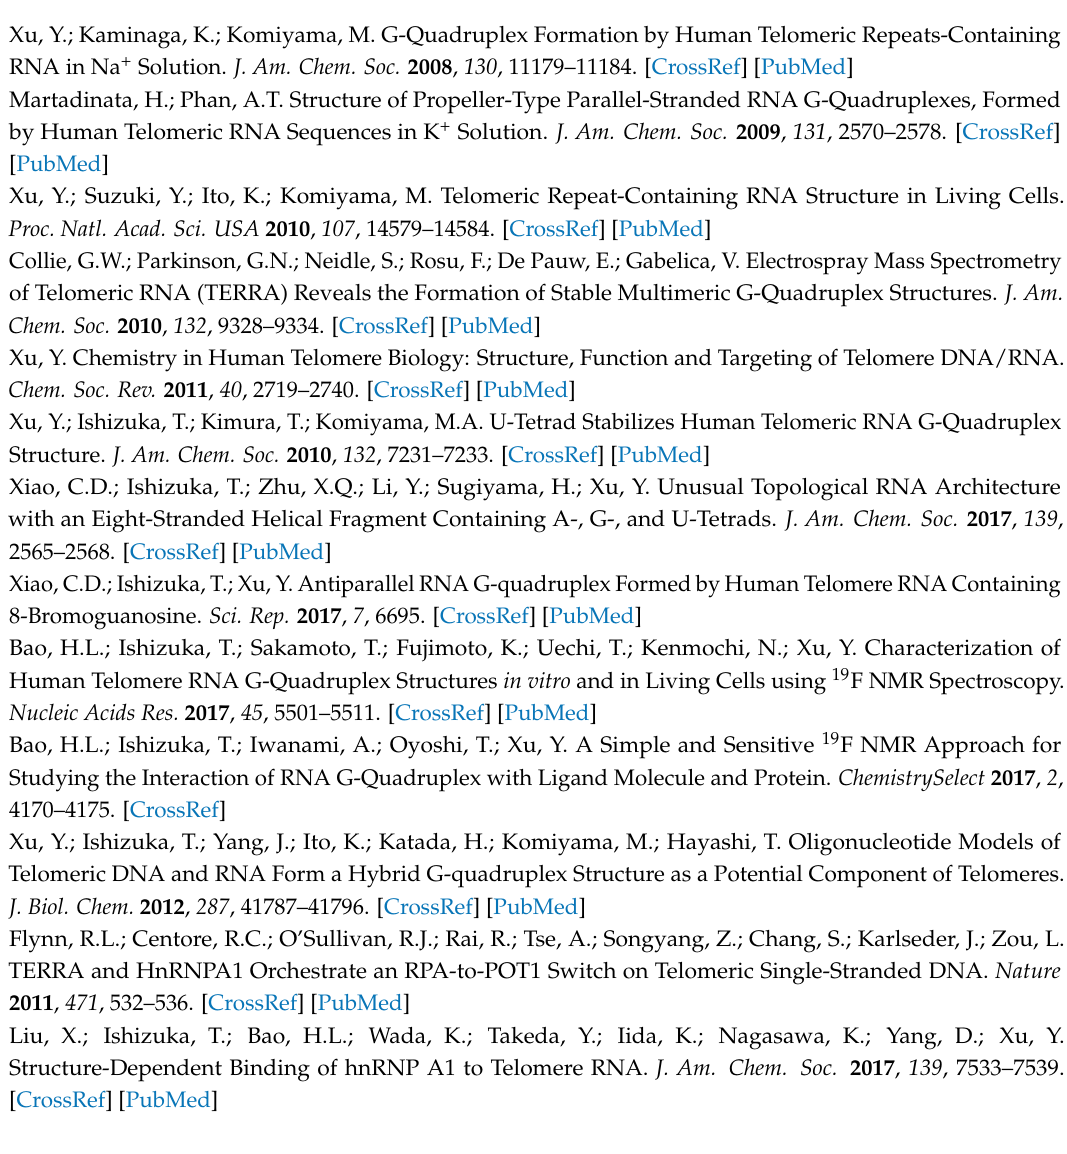
Supplementary Materials: Supplementary materials are available online. Figure S1. CD melting curves for native RNA and modified oligoribonucleotides monitored at 265